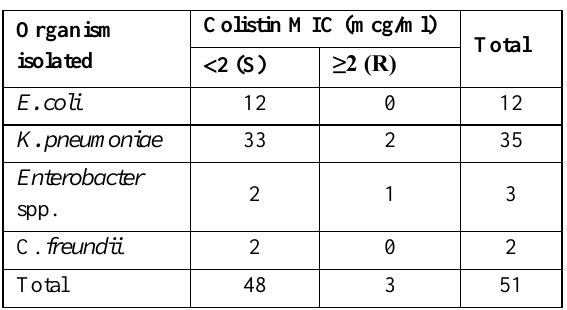
Table 6. Colistin activities in Enterobacteriaceae. Organism